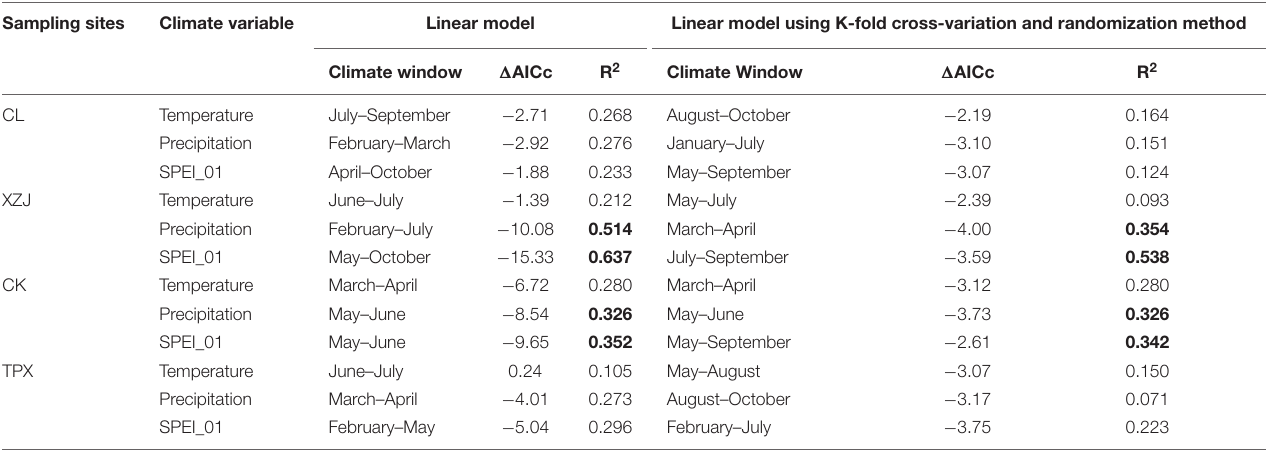
TABLE 4 | Climate-growth relationship based on the “ climwin ”